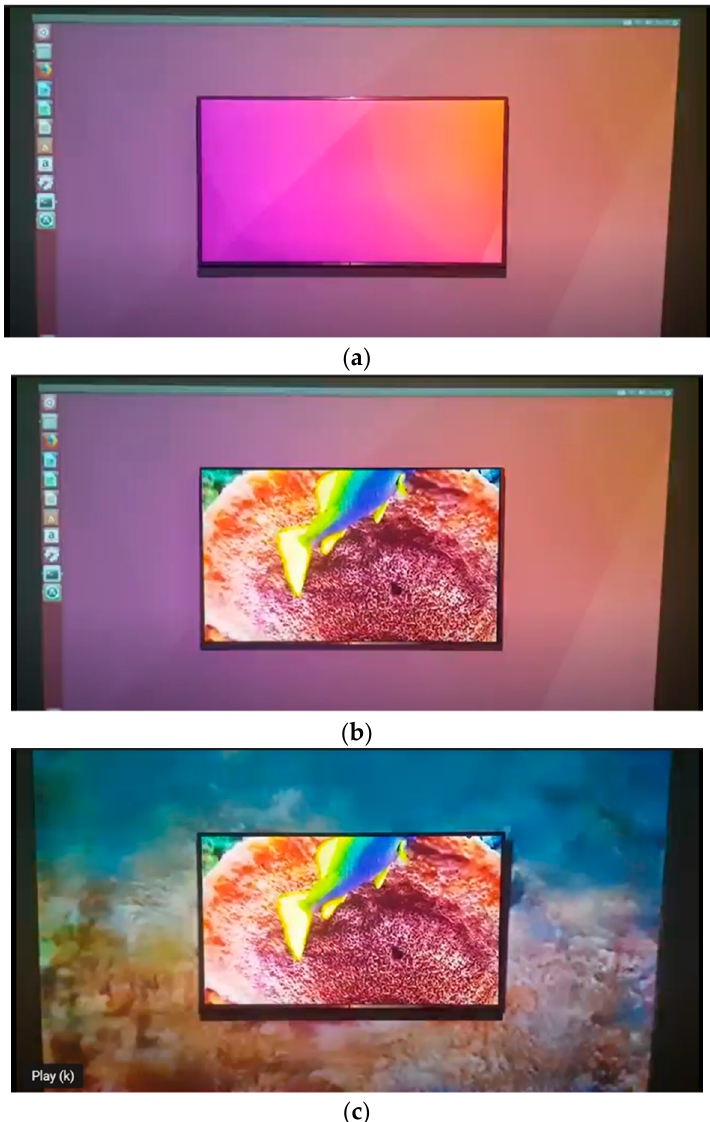
Figure 11. User study ( a ) Default background ( b ) Scene of Effect 1 and ( c ) Scene of Effect